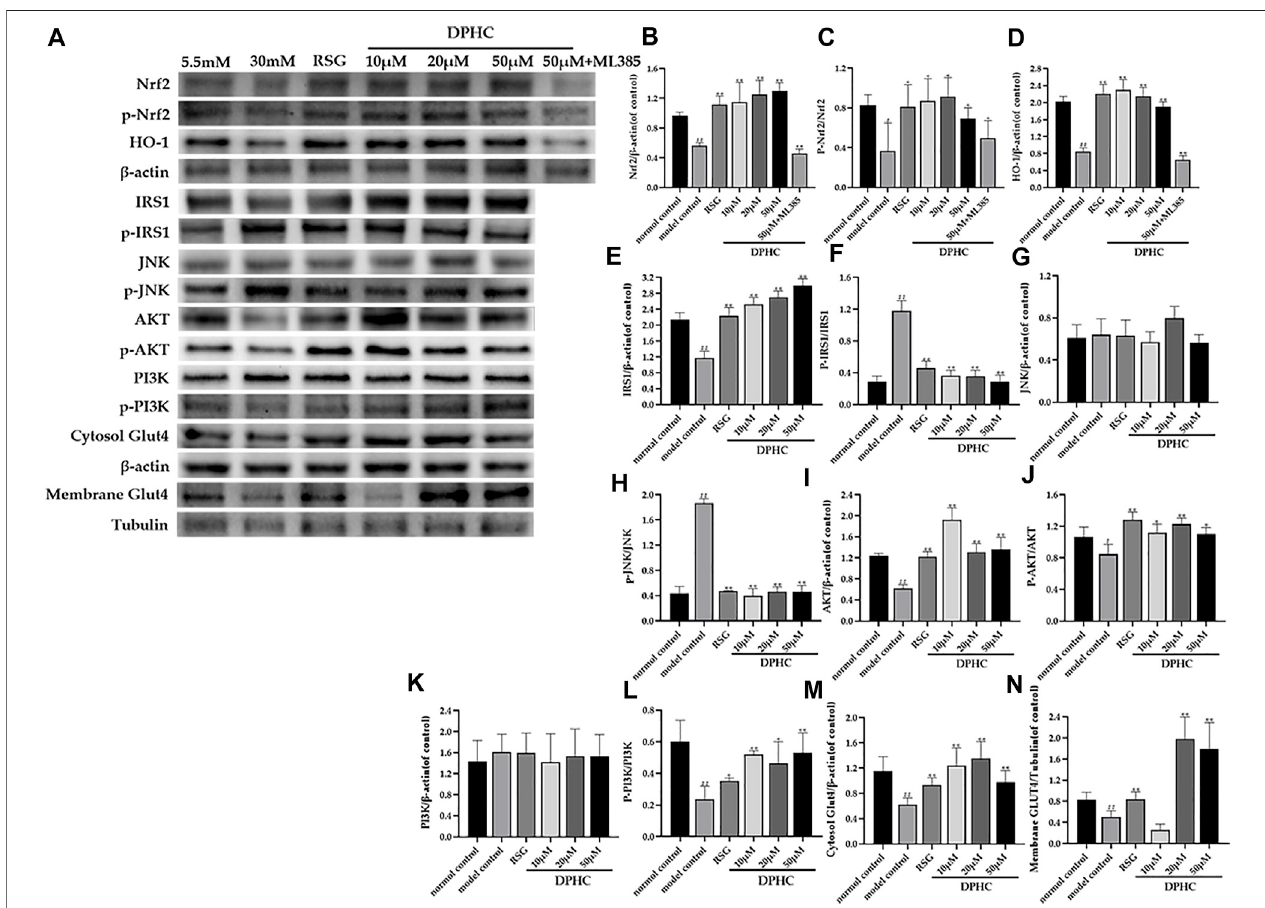
FIGURE 10 | Effects of DPHC on ameliorating oxidative stress and IR via Nrf2/ARE signal pathway-related proteins in IR-HepG2 cells. (A) The expression levels of Nrf2, p -Nrf2, HO-1, JNK, p -JNK, IRS1, AKT, p -AKT, PI3K, p-PI3K, cytosol GLUT4, and membrane GLUT4 in liver tissues ofmice. (B) Nrf2. (C) The ratio of p -Nrf2/Nrf2. (D) HO-1. (E) IRS1. (F) The ratio of p-IRS1/IRS1. (G) JNK. (H) The ratio of p -JNK/JNK. (I) AKT. (J) The ratio of p -AKT/AKT. (K) PI3K. (L) The ratio of p-PI3K/PI3K. (M) Cytosol GLUT4. (N) Membrane GLUT4. All values are expressed as means ± SD, n (cid:1) 3. * p < 0.05, ** p < 0.01 compared with the model control group, and # p < 0.05, ## p < 0.01 compared with the normal control